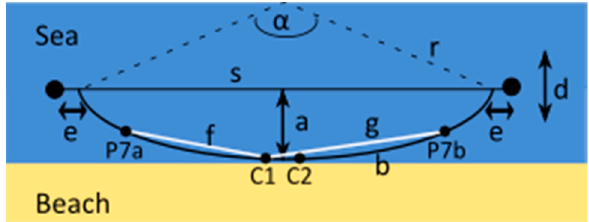
Figure 4. Simplified drawing of measurements carried out parallel to the coastline, causing a deflected streamer, approximated by the height of a small circle segment. α is the center angle of the arc, r is the circle radius, b is the length of the streamer, s is the secant, a is the orthogonal displacement from the midpoint and e is the relative inline displacement. C1 and C2 are the current electrodes, P7a and P7b are the potential electrodes, f is the distance between P7a and C1 respective to P7b and C2 and g is the distance between P7a and C2 respective to P7b and C1.